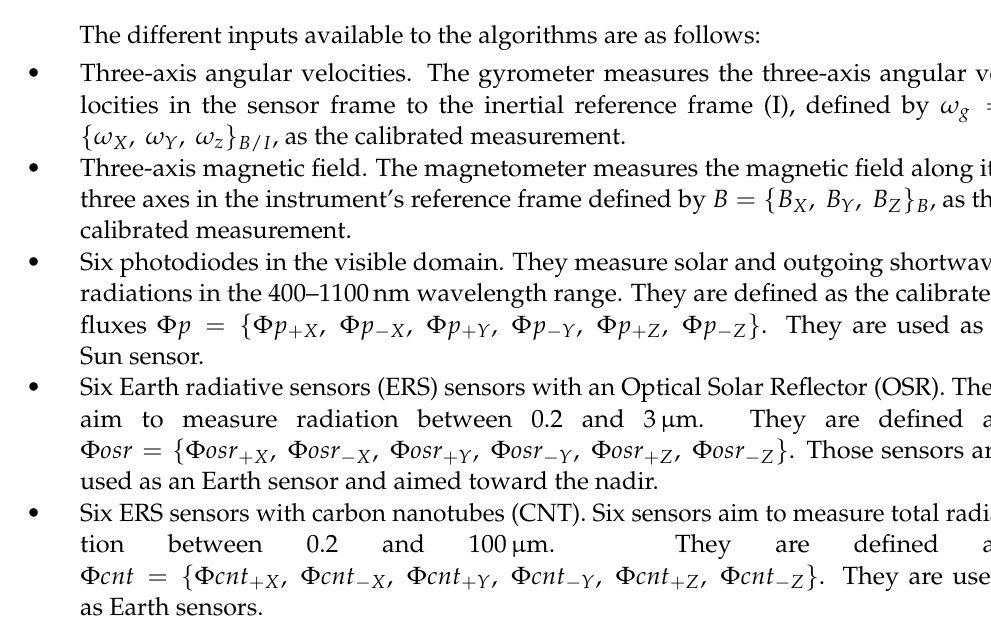
Figure 1. Spacecraft body frame of the UVSQ-SAT